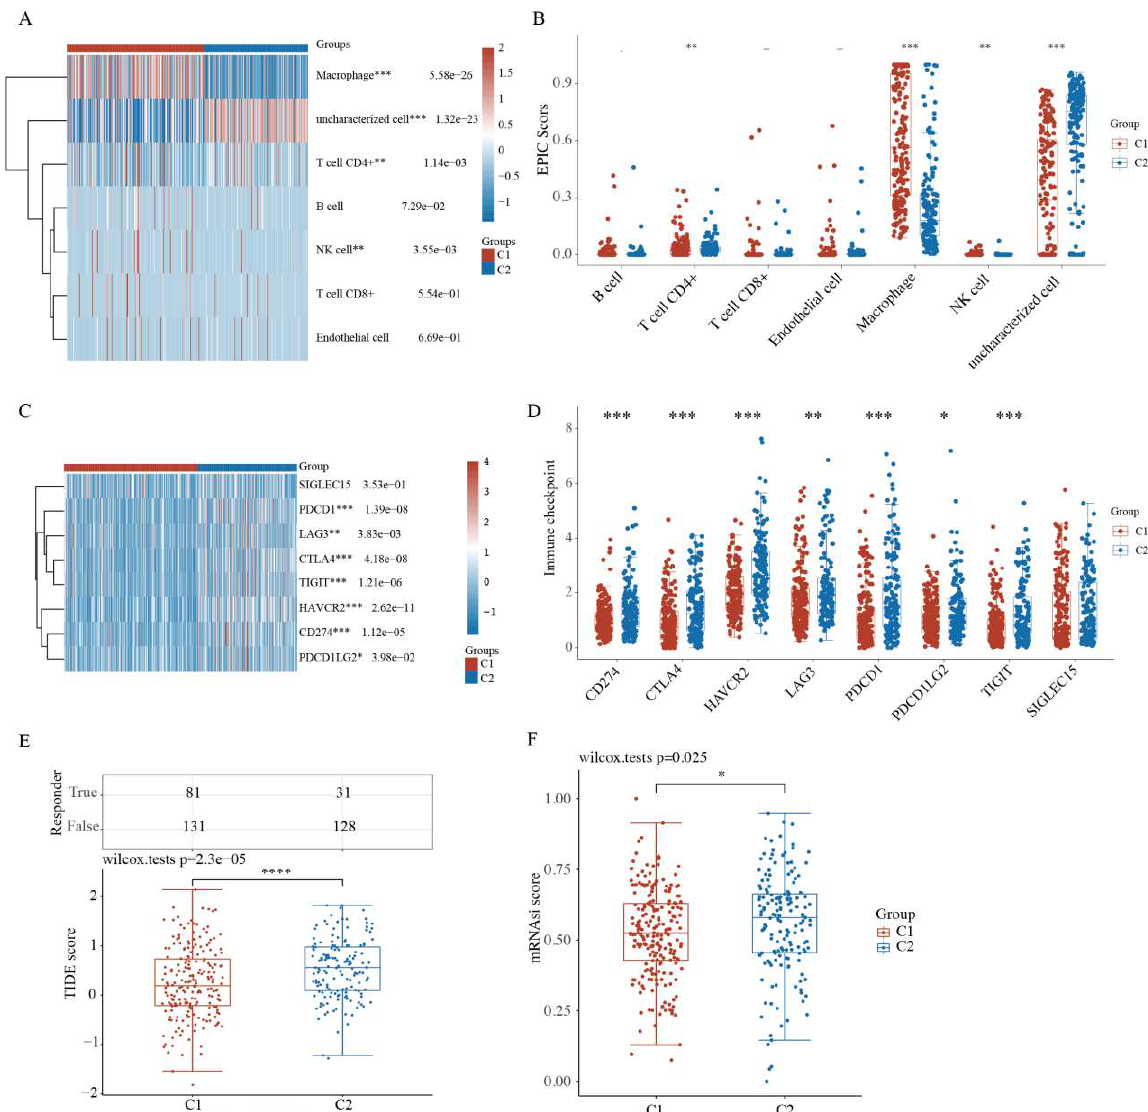
Figure 4. Comparison of the immune activity and tumor stemness between HCC subgroups. ( A ) Immune cell score heatmap by EPIC algorithm. Red represents high expression/score, while blue represents low expression/score. ( B ) Boxplot of immune infiltration status in two clusters by the EPIC algorithm. Heatmap ( C ) and boxplot ( D ) of immune checkpoint-related gene expression be- tween two clusters. Tumor Immune Dysfunction and Exclusion (TIDE) scores ( E ) and cancer stem cell scores ( F ) between two clusters. * p < 0.05, ** p < 0.01, *** p < 0.001, **** p < 0.0001.